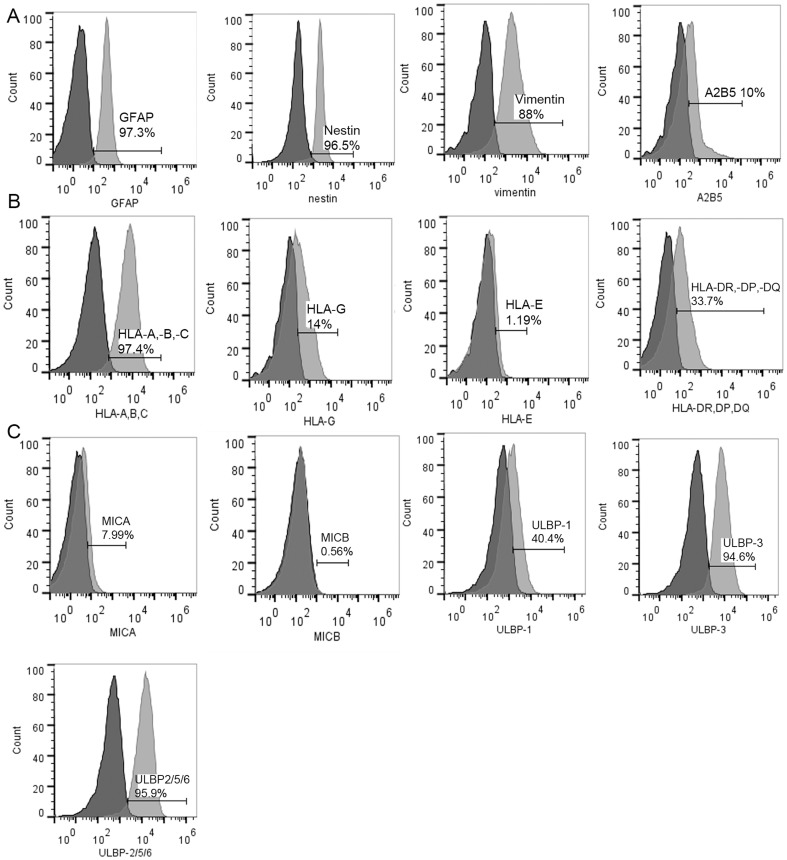
Expression of glial cell markers and NK cell ligands on U87MG tumour cells.(A) Mean Fluorescence Intensity (MFI) histograms and % cells expressing glial markers (GFAP,Nestin, Vimentin, and A2B5), (B) MFI histograms and % cells expressing class I HLA ligands (HLA-A,-B,-C), non-classical HLA-G and HLA-E, as well as HLA-DR,DP,DQ. (C) MFI histograms and % cells expressing ULBP 1, 3, 2/5/6, MICA and MICB activating ligands. Dark histograms represent negative control, light histograms represent stained cells.